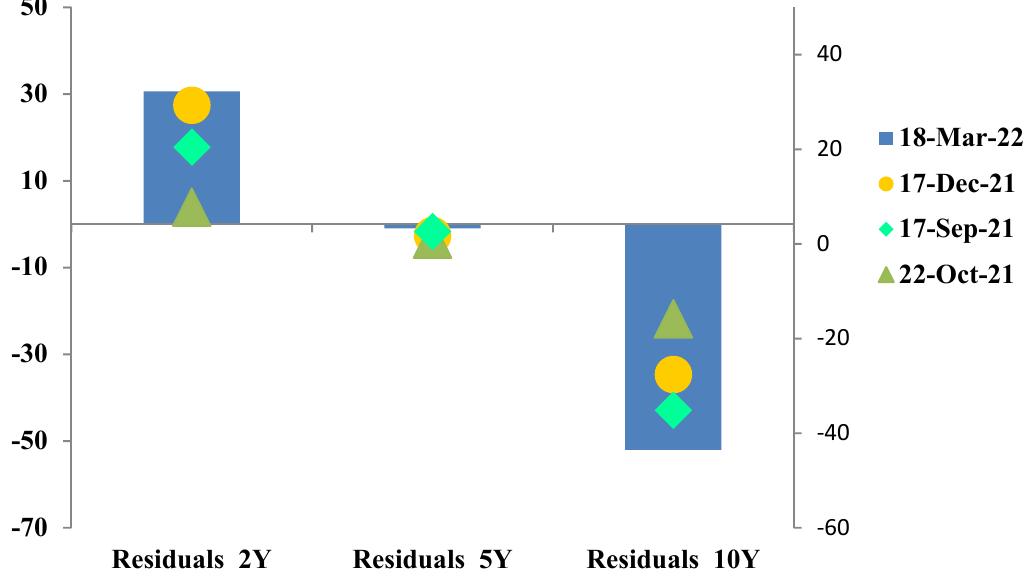
Figure 13. PCA residuals (in basis points) signaling “too flat” yield curves. Source: Own computation of PCA residuals.